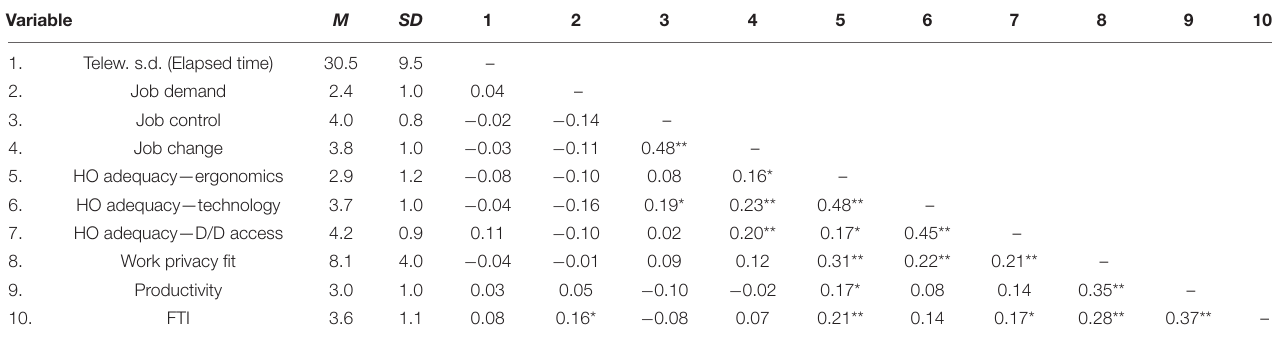
TABLE 2 | Means, standard deviations, and correlations between study